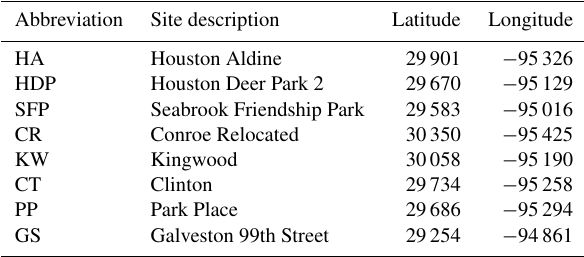
Figure 3. Comparisons of 24h averaged PM 2 . 5 mass concentrations (unit: µgm − 3 ) between the model simulation D1_MOR_anth (con- toured) and the site observations from TCEQ (colored circles) from 18:00UTC on 18 June 2013 to 18:00UTC on 19 June 2013 (1d be- fore the convection initiation). The site names and other information are shown in Table 1. Table 1. Descriptions of the PM 2 . 5 monitoring sites over the Hous- ton area from